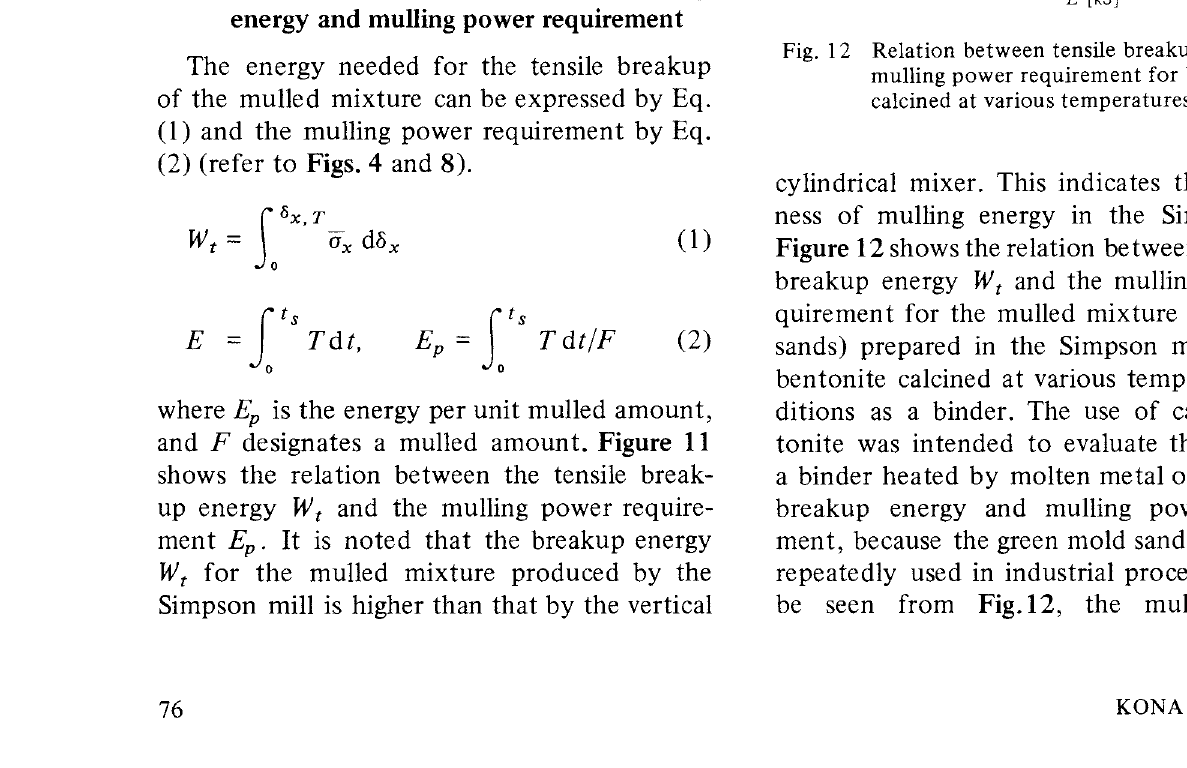
Fig. 12 Relation between tensile breakup energy and mulling power requirement for bentonites calcined at various temperatures